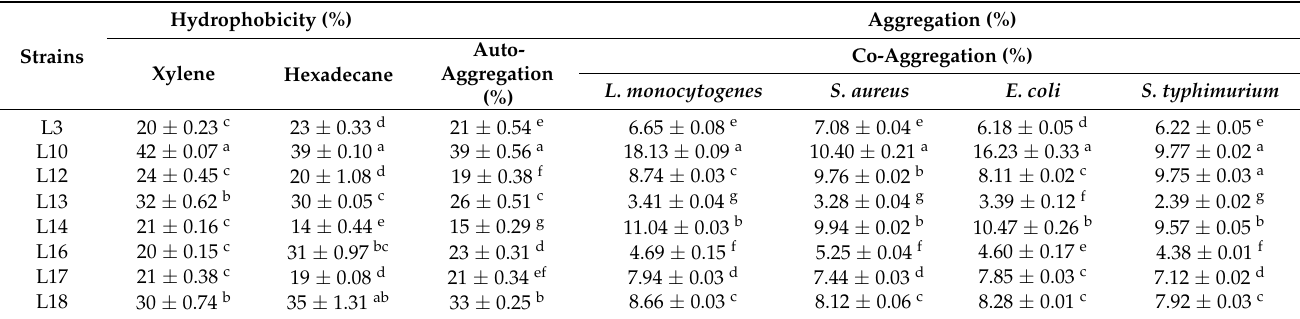
Table 3. Hydrophobicity and aggregation of the selected 8